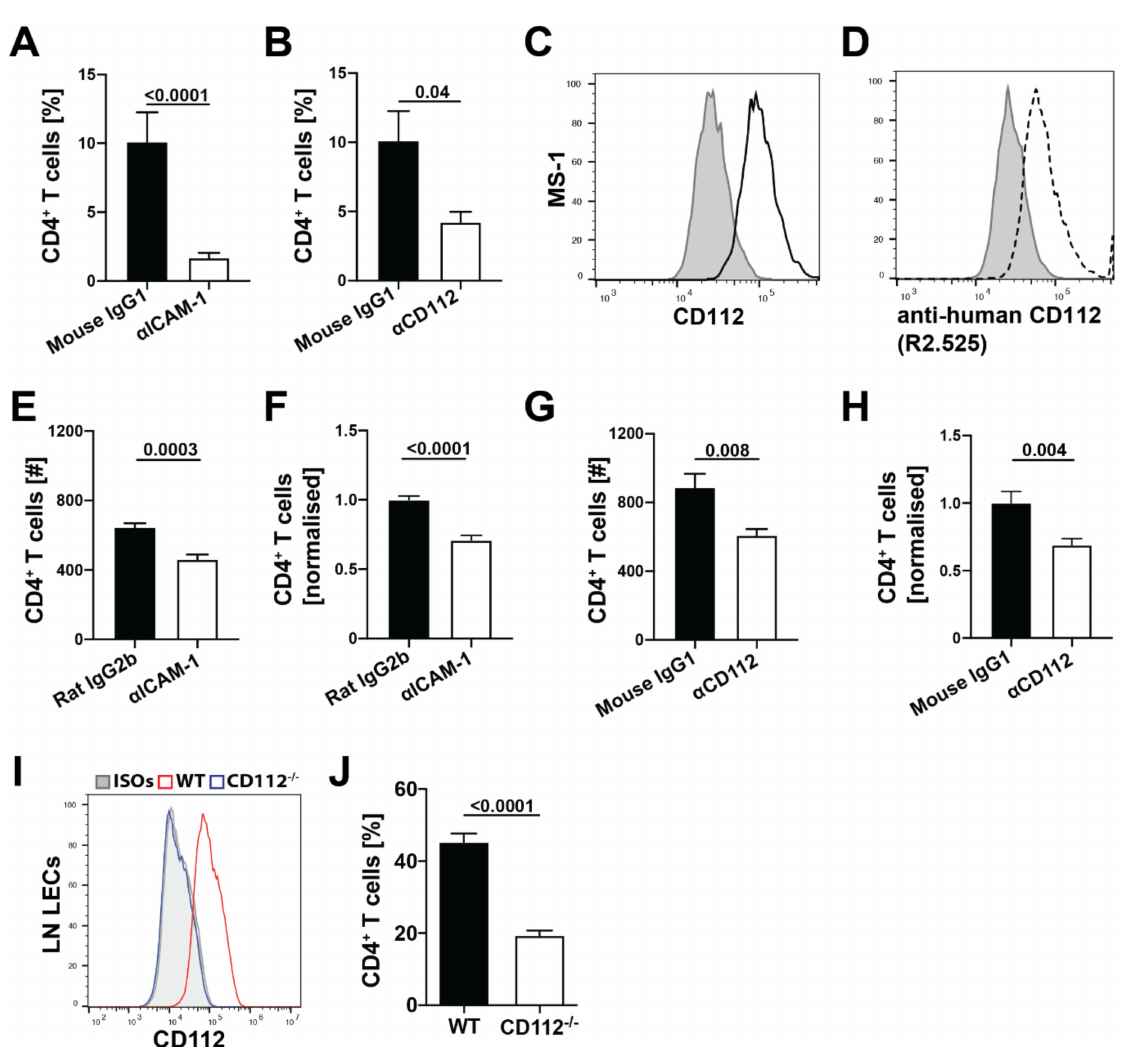
Figure 4. CD112 regulates CD4 + T cell transmigration through BECs in vitro. ( A , B ) In vitro transmigration assay with human T cells and primary human LECs. Quantification of transmigration efficiency upon either ICAM-1 antibody blockade (clone BBIG-I1, mouse IgG1) ( A ) or CD112 antibody blockade (clone R2.525, mouse IgG1) ( B ). Pooled data from three similar experiments are shown ( n = 3 replicates per group and per experiment, i.e., 9 per pooled group). ( C ) Flow cytometry analysis showing CD112 protein expression by cultured blood vascular MS-1 cells. Representative histograms from three independent experiments are shown (black: CD112, grey: isotype control). ( D ) Representative histograms demonstrating the cross-reactivity of mouse anti-human CD112 antibody (R2.525, R&D systems) with mouse CD112 (black doted: antibody binding to CD112; grey: isotype controls). ( E – H ) In vitro transmigration assay of freshly isolated murine CD4 + T cells across blood vascular MS-1 monolayers in presence of anti-ICAM-1 (clone YN1, rat IgG2b) ( E , F ) or anti-CD112 (clone R2.525, mouse IgG1) ( G , H ). The number of transmigrated T cells was quantified by flow cytometry after 4 h. ( E , G ) show absolute numbers of transmigrated cells and ( F , H ) show values normalized to the isotype control. Pooled data from three similar experiments are shown ( n = 3 replicates per group and per experiment, i.e., 9 per pooled group). ( I ) Representative histogram showing CD112 expression in WT (red) and CD112 − / − (blue) primary LN LECs compared to isotype controls (grey). Data from one out of three independent experiment are shown. ( J ) In vitro transmigration of freshly isolated murine CD4 + T cells across primary WT or CD112 − / − LN LECs. Pooled data from four similar experiments are shown ( n = 4 replicates per group and per experiment, i.e., 12 per pooled